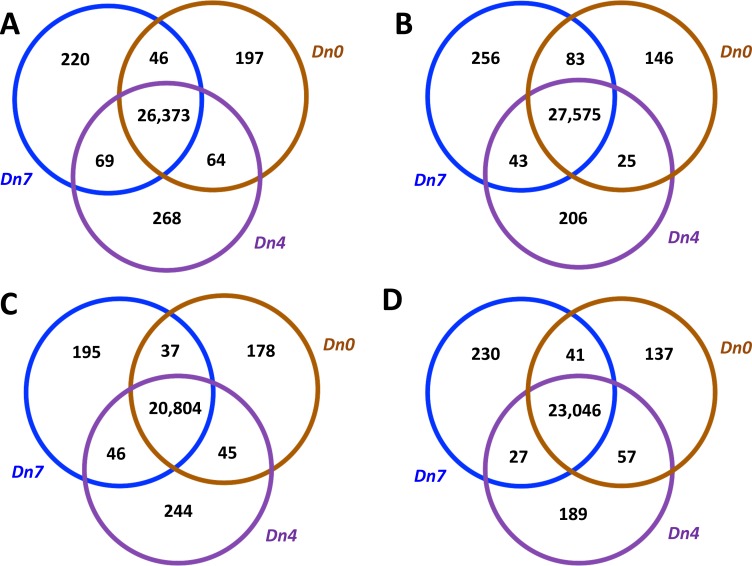
Venn Diagram depicting total numbers of differentially expressed transcripts and genes in D. noxia fed wheat plants containing Dn genes for susceptibility (Dn0 [brown circles]), biotype 1 resistance (Dn4 [purple circles]) or biotype 2 resistance (Dn7 [blue circles]).A (transcripts) and B (genes) in biotype 1, C (transcripts) and D (genes) in biotype 2.